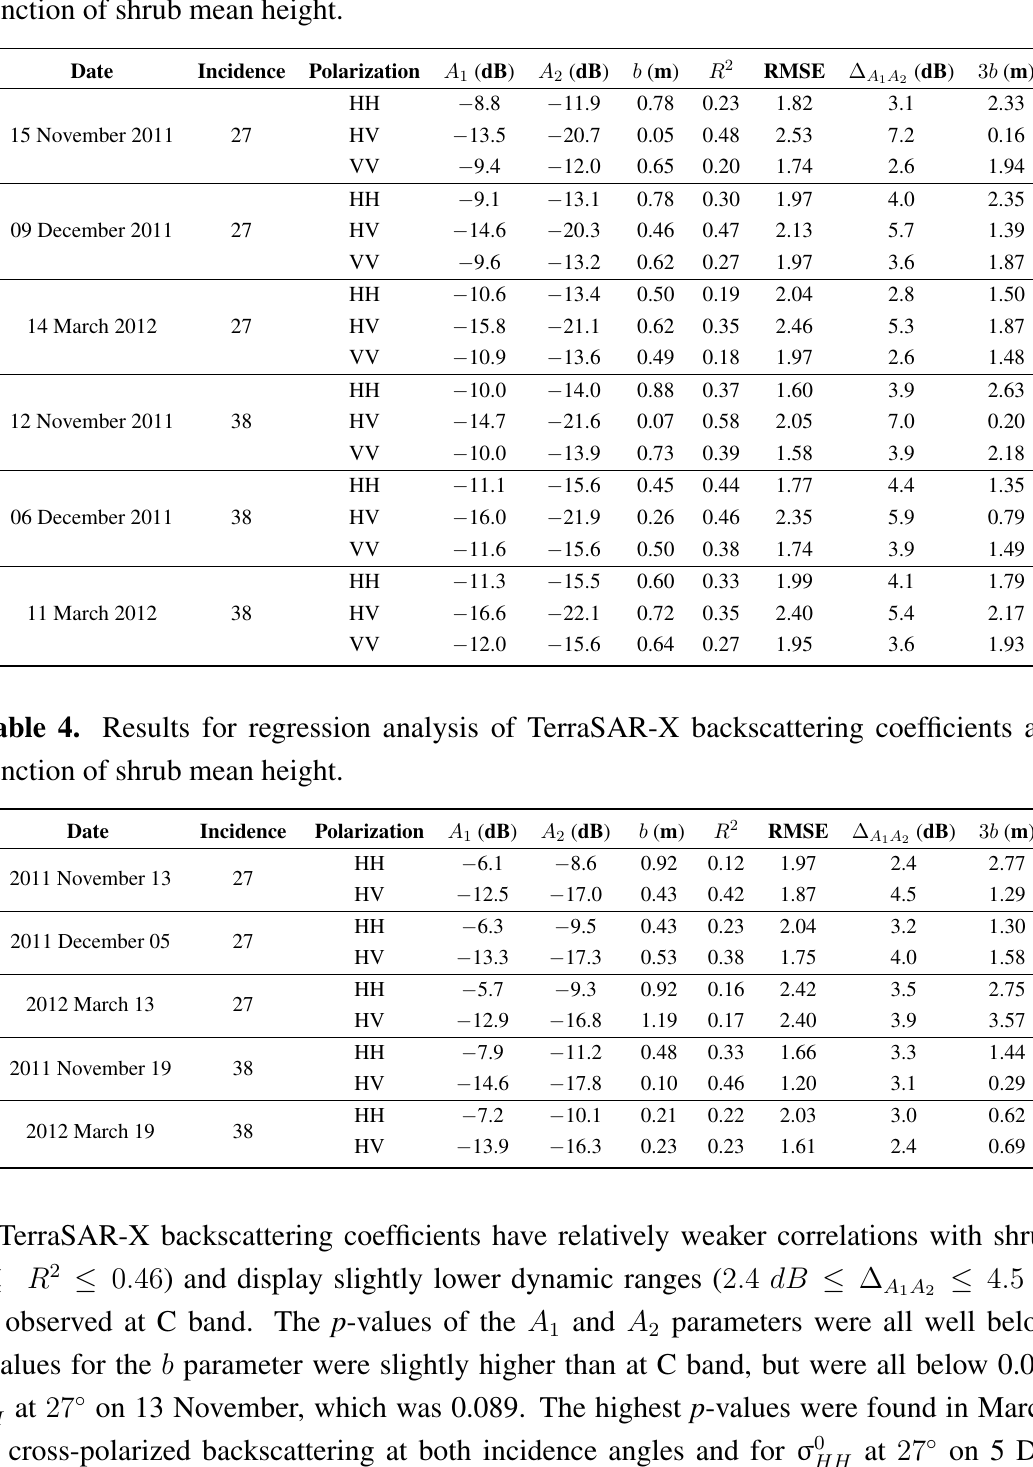
Table 3. Results for regression analysis of RADARSAT-2 backscattering coefficients as a function of shrub mean height.